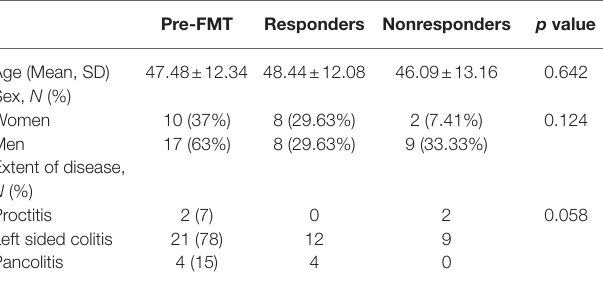
TABLE 1 | Baseline characteristics of